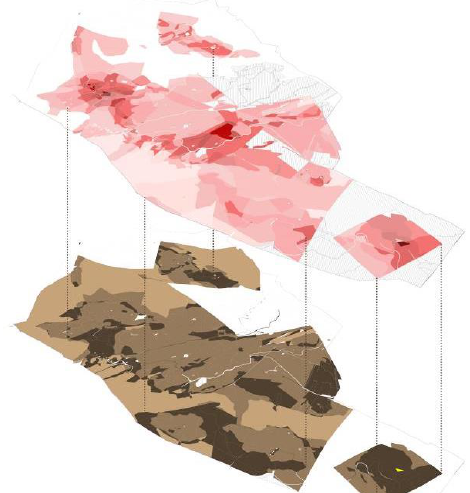
Figure 14 . Great War Impact Factor and trajectories of landscape’s change: general overlapping